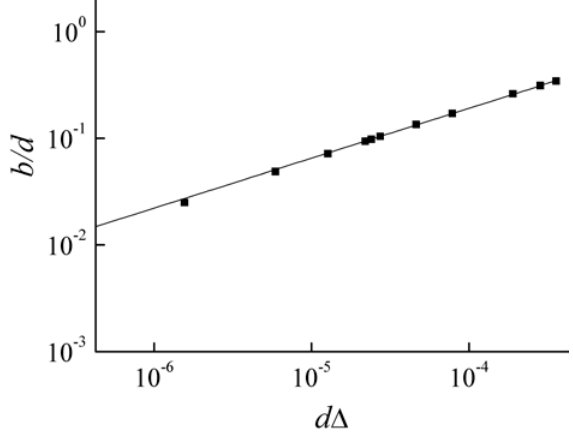
Figure 10. The dependence of the coefficient b in (3) on the distance ∆ (along the frequency axis) between the boundaries A and B of degenerate and Brillouin BGs. The parameters for the PCs are cited in the text. The squares are the result of numerical simulations, the solid line is a trend